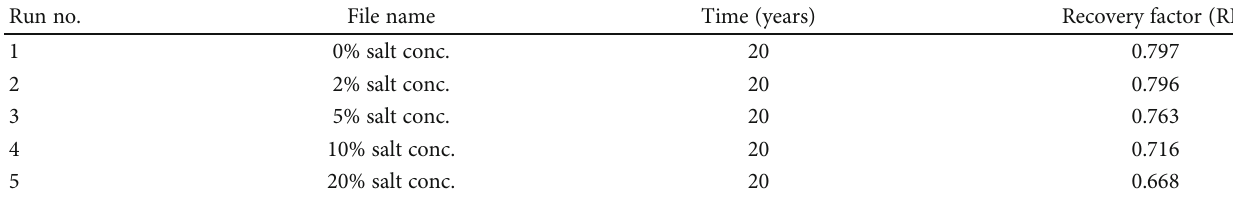
Table 6: Oil recovery factor for Case 2.